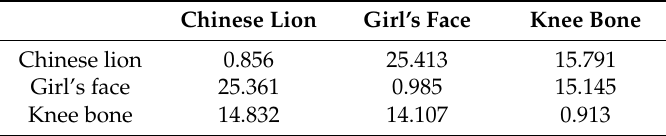
Table 1. Recognition data ( D max [mm]).